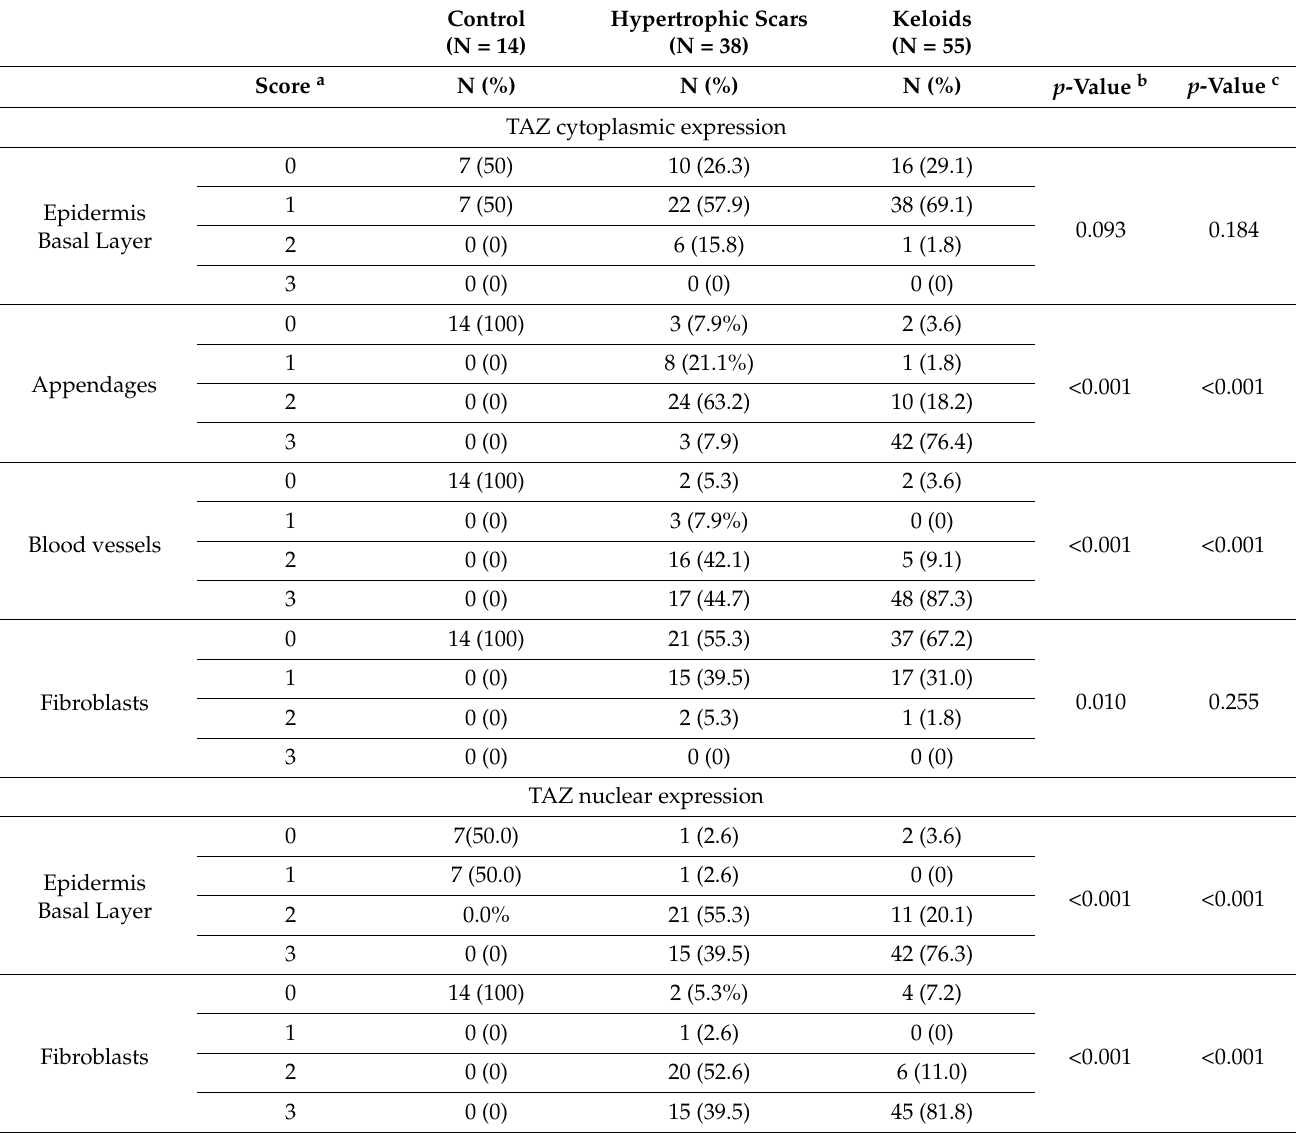
Table 3. Immunohistochemical analysis of TAZ expression in control skin, hypertrophic scars and